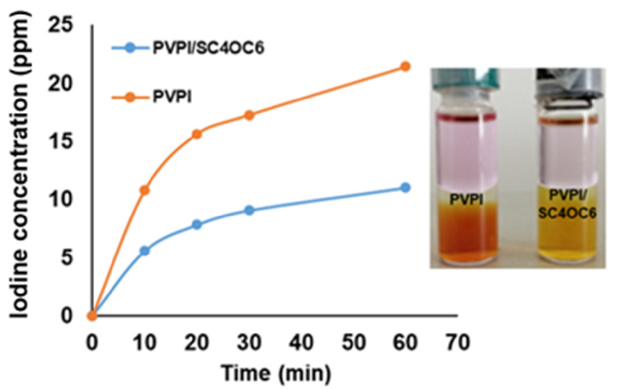
Figure 10. Diffusion of molecular iodine from 0.1% PVPI buffered solution (1 mL) to cyclohexane (1 mL) in the absence and in the presence of SC4OC6 (0.25 mg/mL) at different time intervals (5, 10, 20, 30, and 60 min); inset: picture of the samples after 24 h.